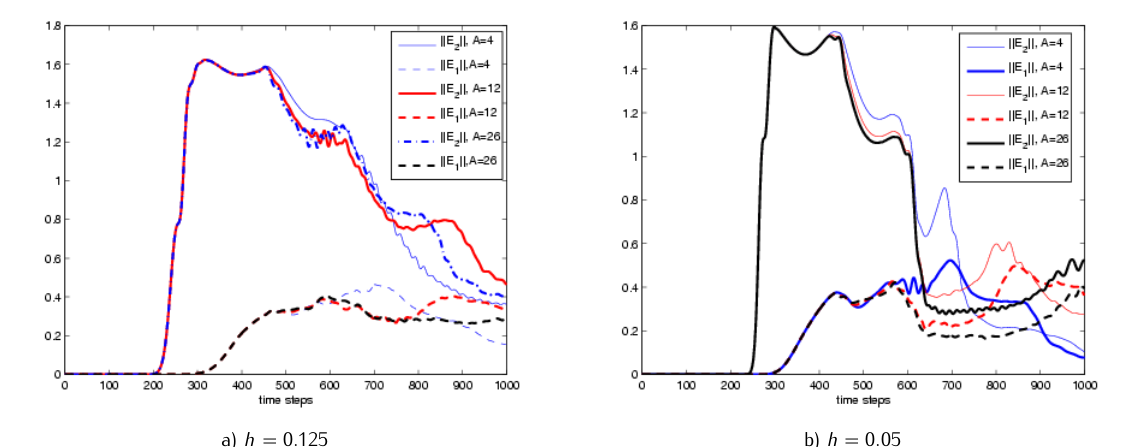
, E , E . E E E 1 = 2 2 = 1 3 = 3